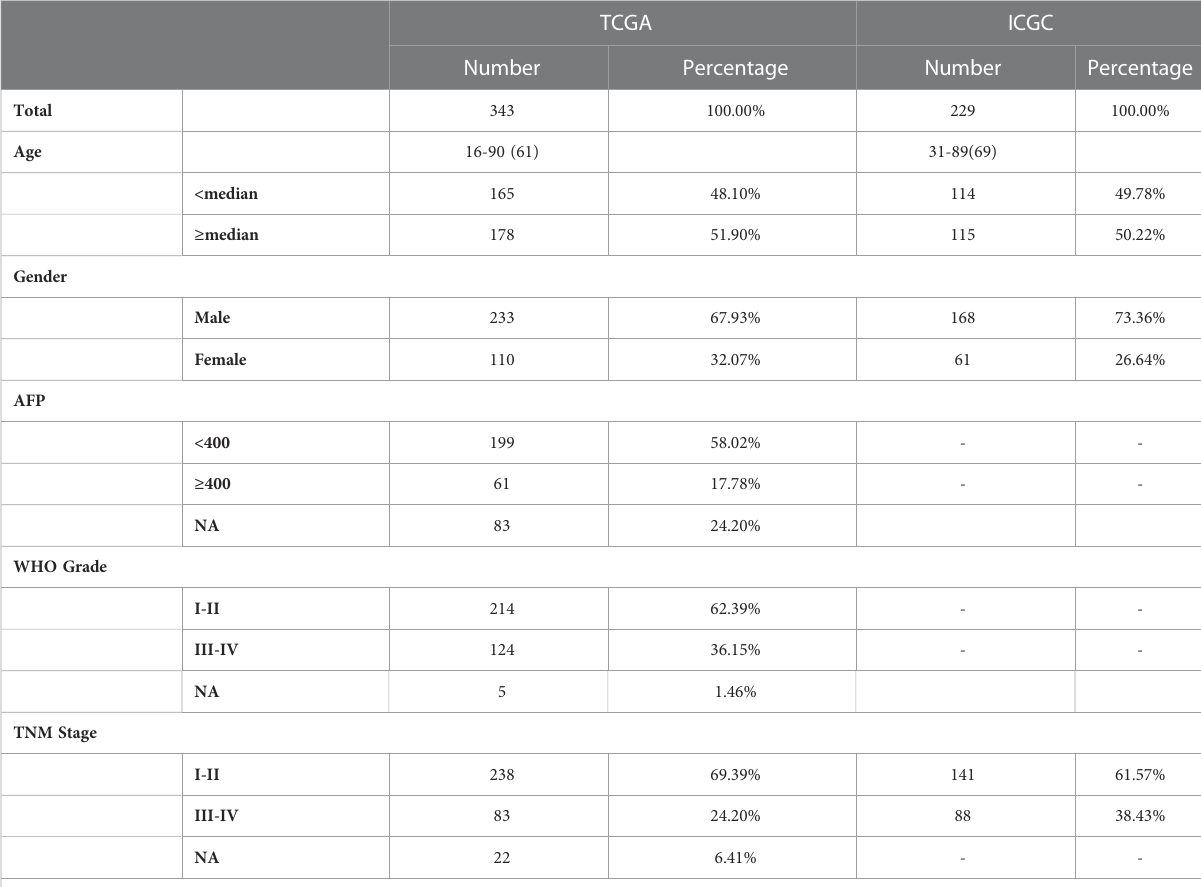
TABLE 1 Clinicopathological data of each cohort in our